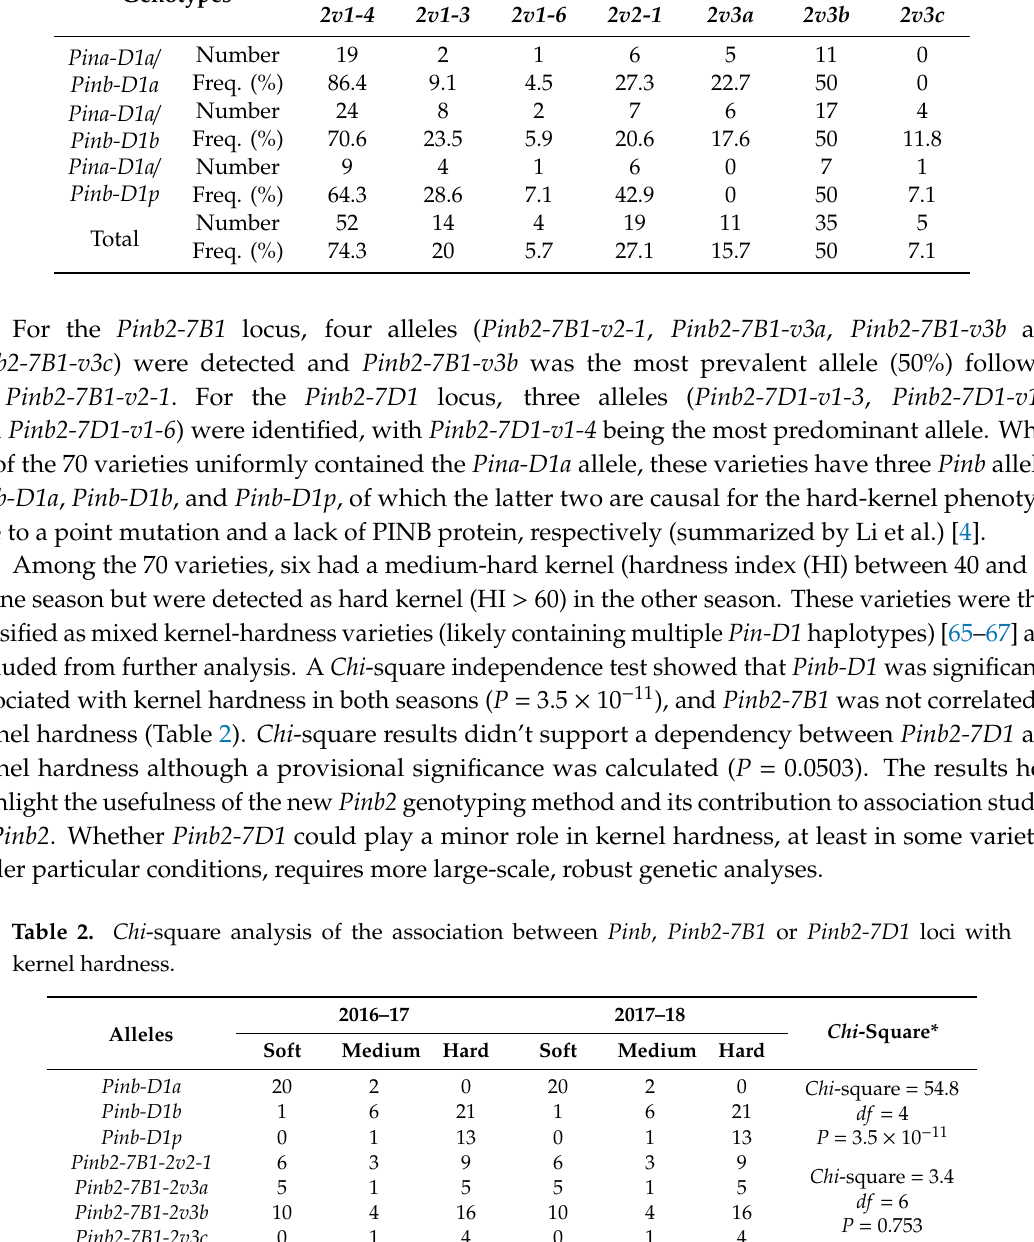
Table 1. The distribution and frequency of Pina , Pinb and Pinb2 for the 70 Chinese wheat varieties. Genotypes